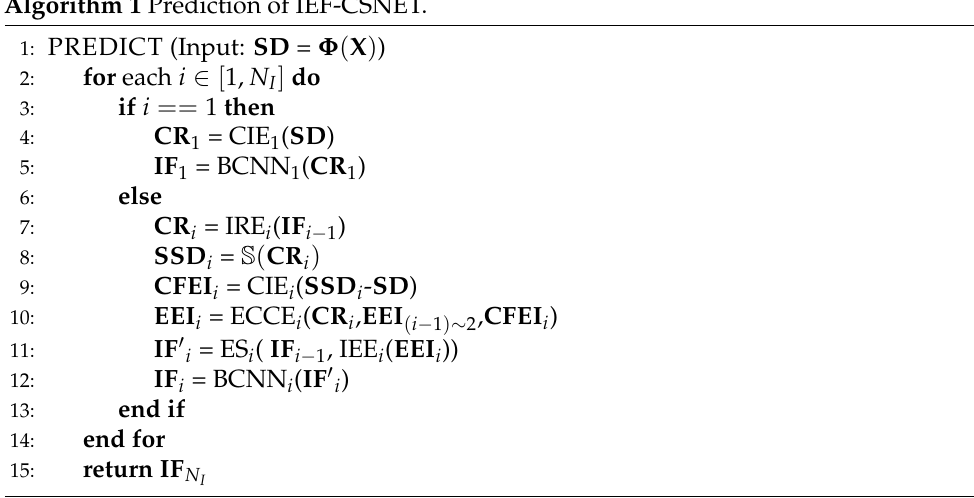
Algorithm 1 Prediction of